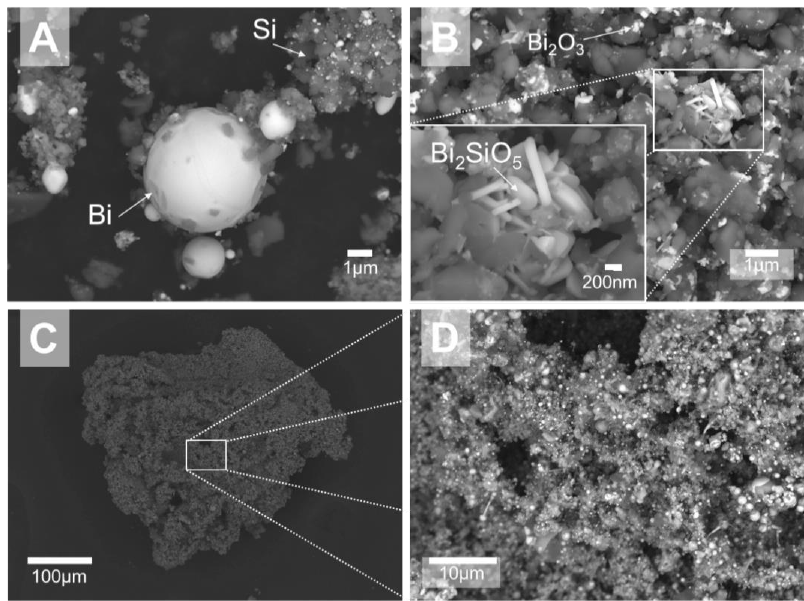
Figure 7. Backscattered electron images of the two-stage milled composite 50Si · 50BiF 3 heated at 5 K / min and recovered from 973 K (700 ◦ C): ( A ) in Ar, ( B ) in Ar / O 2 and recovered from 1473 K (1200 ◦ C) in Ar ( C , D ).